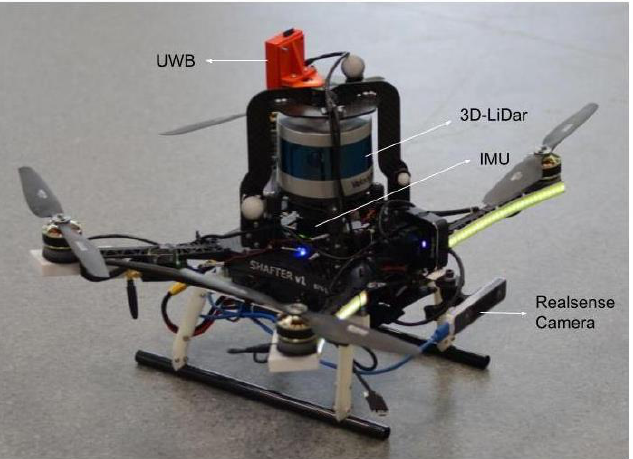
Figure 1. The aerial robot considered with the heterogeneous and asynchronous sensors for estab- lishing the multi-layer sensor fusion